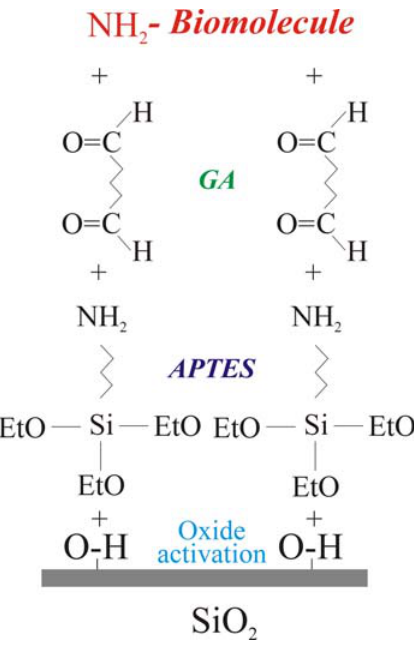
Figure 1. Schematic structure of the probe immobilization protocol. The four immobilization steps, oxide activation, silanization, linker molecule deposition and biological molecule immobilization are indicated as: oxide activation, APTES, GA, terminated), biomolecule (NH 2